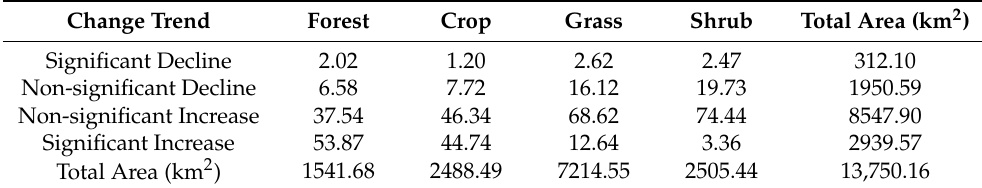
Table 1. Proportion of area with different VG trends (%).